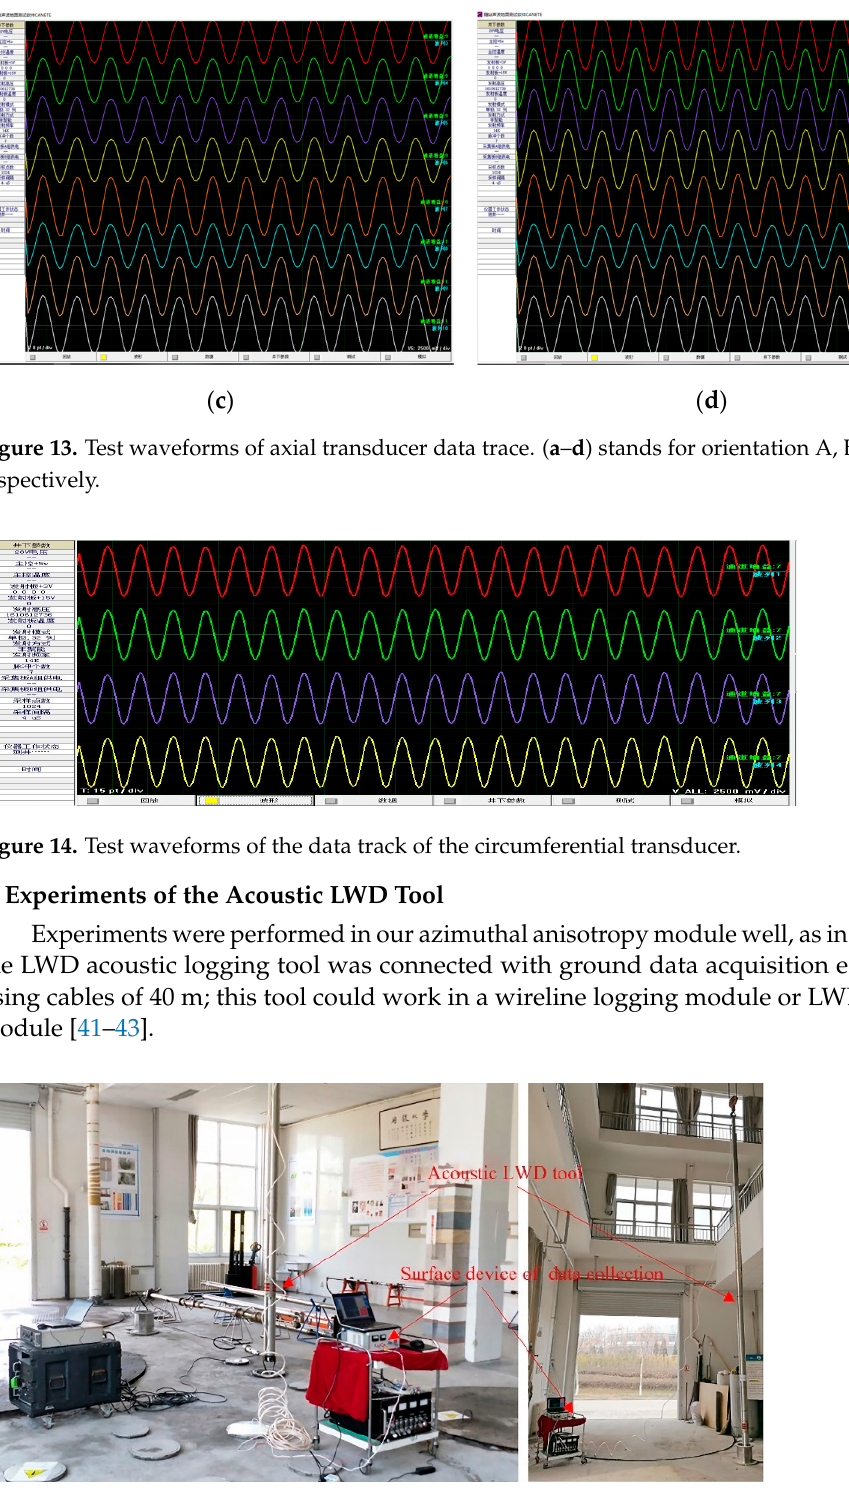
Figure 15. Acoustic LWD testing in room well group.